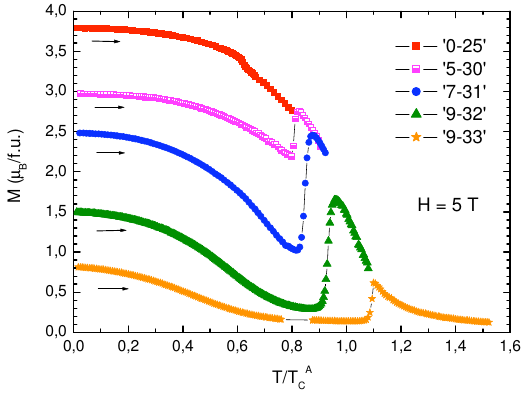
Fig. 2. Magnetization of selected alloys at field 5 T as a function of T/T CA .